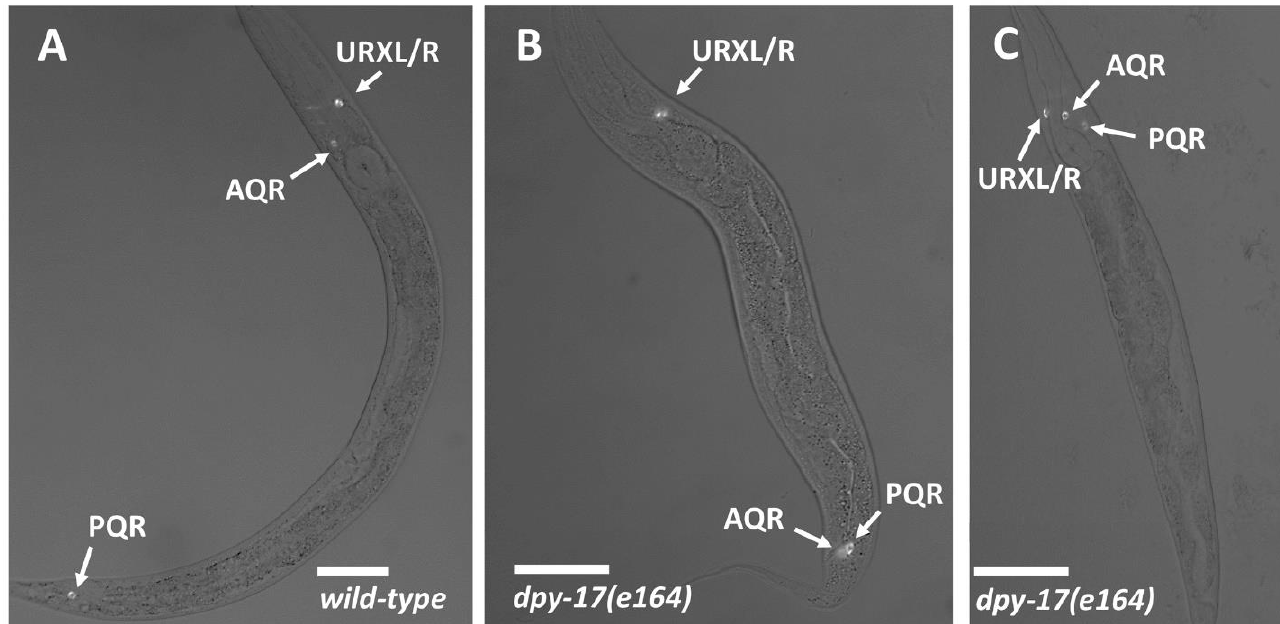
Figure 2. AQR and PQR positions. Micrographs of L4 animals expressing lqIs244[Pgcy-32::cfp] in AQR, PQR, and the left and right URX neurons, which reside next to one another and are indistinguishable in these micrographs. Scale bars represent 20 µ m. Fluorescence images are merged with differential contrast interference (DIC) images. ( A ) In wild-type, AQR resides in the anterior in the anterior deirid near the pharynx, and PQR resides posterior to the anus in the phasmid ganglion. ( B ) In a dpy-17(e164) mutant, AQR had migrated posteriorly near to the normal position of PQR. ( C ) In a dpy-17(e164) mutant, PQR migrated anteriorly to reside near AQR.